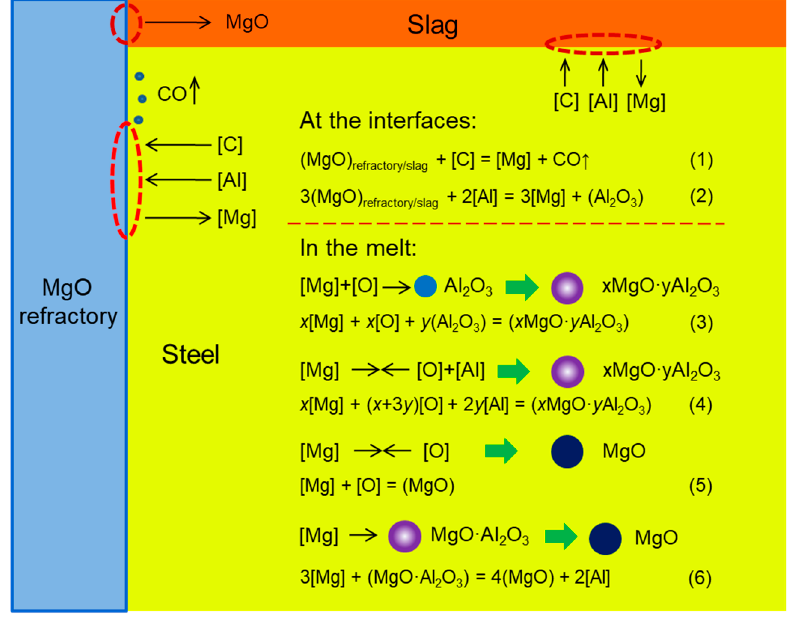
Figure 4. Illustration of inclusion formation in molten steel in MgO crucibles.